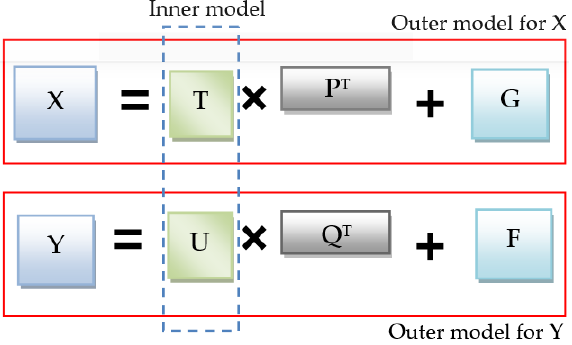
Figure 4. General design of PLS model.